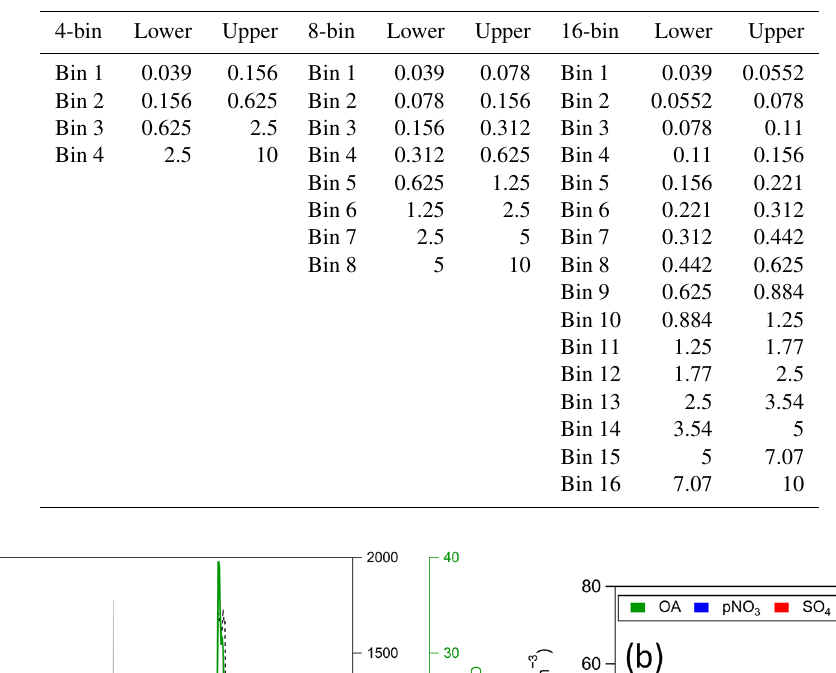
Table 3. Lower and upper diameters (µm) for the 4, 8, and 16 size bin configurations.